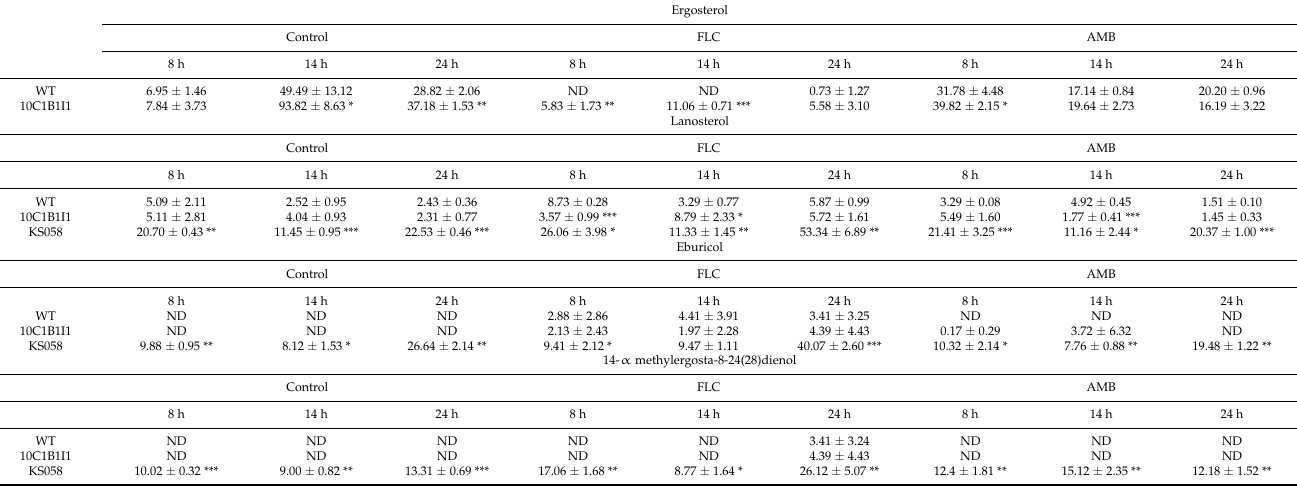
Table 1. The sterol analysis ( µ g/mg of the dry mass of isolated lipids; ± SD; n = 3; ND–not detected) determined for the C. albicans SC5314 wild type (WT), ERG11 K143R/K143R (10C1B1I1), and erg11 ∆ / ∆ (KS058) strains in different growth times (8, 14 and 24 h) and under different culture conditions: control (YPD medium alone), with the addition of FLC (4 µ g/mL), or AMB (0.25 µ g/mL). The sterol content was determined using the GC-MS method. Statistical analysis was performed by comparing the amounts of specific sterols in 10C1B1I1 or KS058 against the WT strain at each time point and under each culture condition (*, p < 0.05; **, p < 0.01; ***, p < 0.001). Ergosterol Control FLC AMB